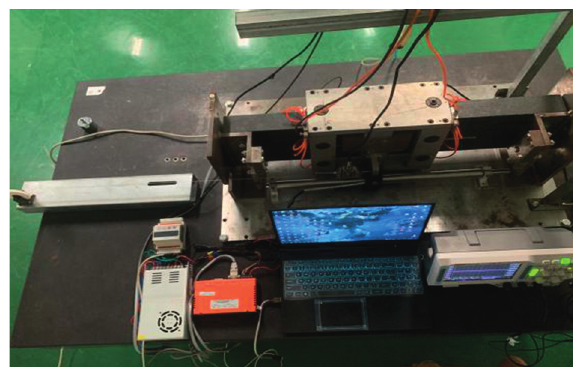
Figure 20: Experimental platform.